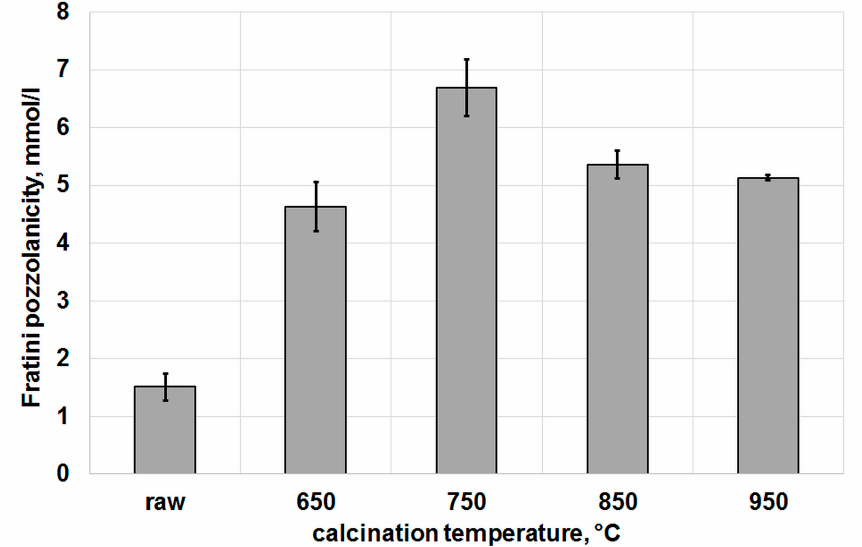
Figure 4. Values of the Fratini pozzolanity vs. calcination temperature.